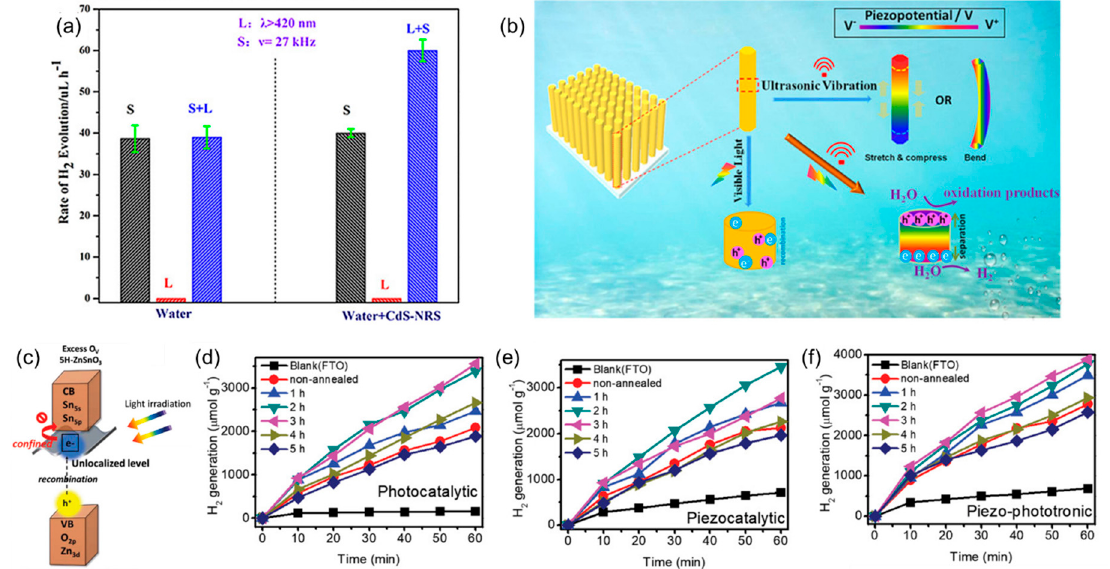
Figure 5. ( a ) H 2 production rate at different conditions. ( b ) Mechanism of CdS-NRs piezo-phototronic effect in H 2 generation under visible light and ultrasonic excitation. ( c ) Schematics of ZnSnO 3 water splitting system with the piezo-phototronic effect. The amount of H 2 production of ZnSnO 3 NWs as a function of time under ( d ) only light irradiation, ( e ) only ultrasonic vibration, and ( f ) both light and ultrasonic vibration simultaneously. ( a – b ) Reproduced from [56], Copyright 2018, Wiley-VCH Verlag GmbH & Co. KGaA, Weinheim. ( c – f ) Reproduced from [63], Copyright 2019, Wiley-VCH Verlag GmbH & Co. KGaA, Weinheim.